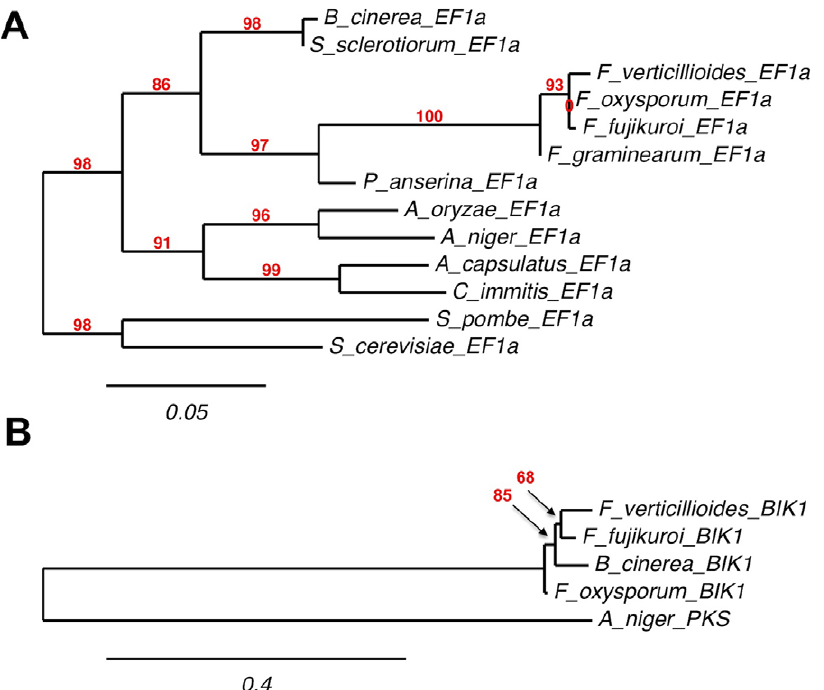
Figure 2. Comparative phylogenies of the conserved elongation factor EF1 a and the BIK1. Maximum likelihood phylogenies from alignments of the protein sequences were estimated using the PhyML program with the substitution model WAG and a number of bootstraps of 100 [52] (http://www.phylogeny.fr). A. Phylogeny of EF1 a represents the evolution of fungal species. Selected proteins are from Botrytis cinerea (BROAD: BC1G_09492.1), Sclerotinia sclerotiorum (GenBank: EDO03042.1), Fusarium verticillioides (BROAD: FVEG_02381.3), Fusarium oxysporum